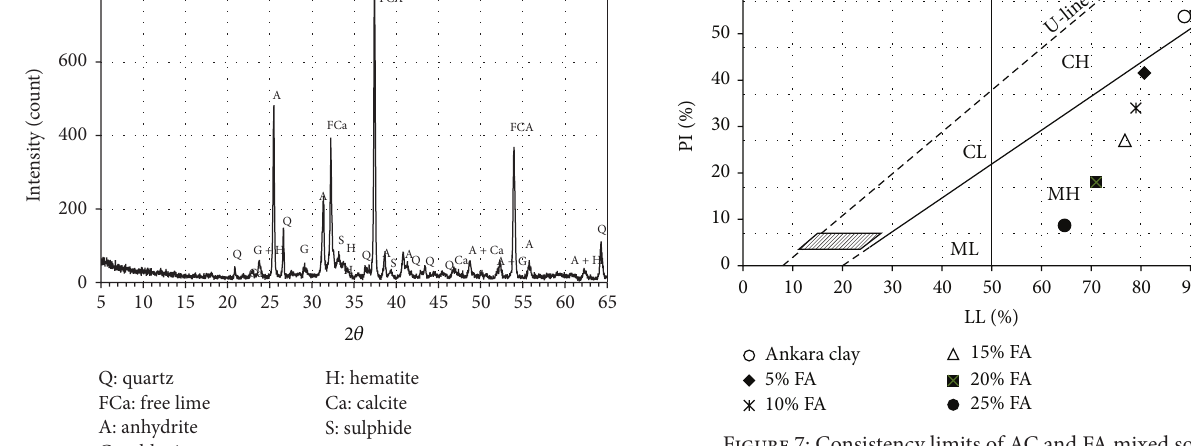
Figure 7: Consistency limits of AC and FA mixed soil. Table 4: Compaction characteristics of testing soil mixed with